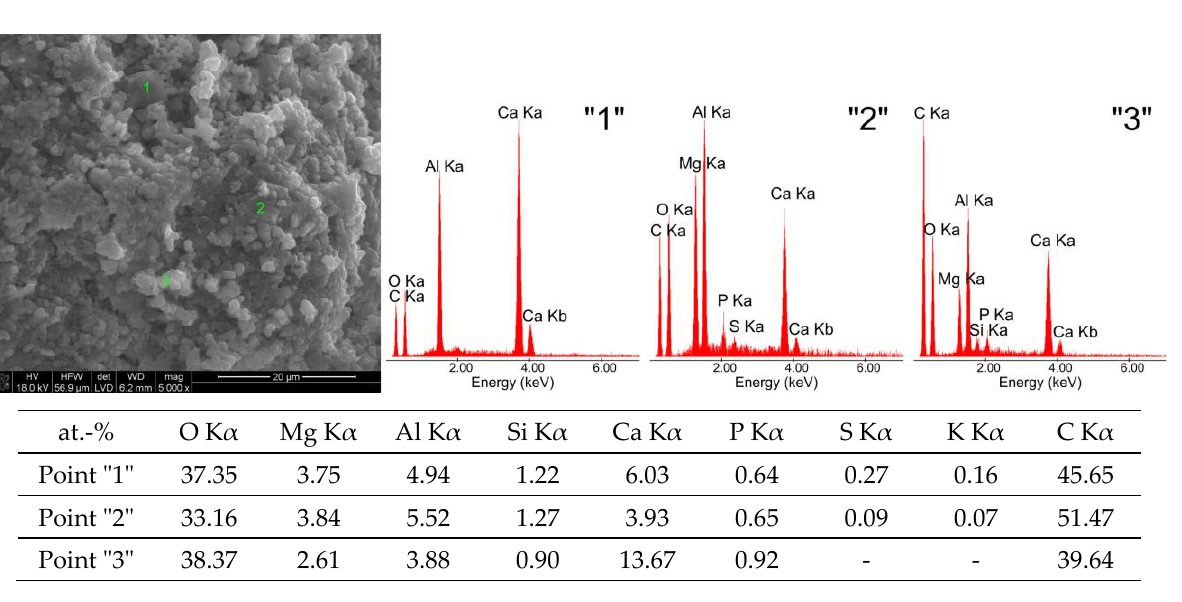
Figure 5. SEM microphotographs of tricalcium aluminate after exposure to corn silage (K) and EDS quantitative point analyses of areas 1, 2, 3.